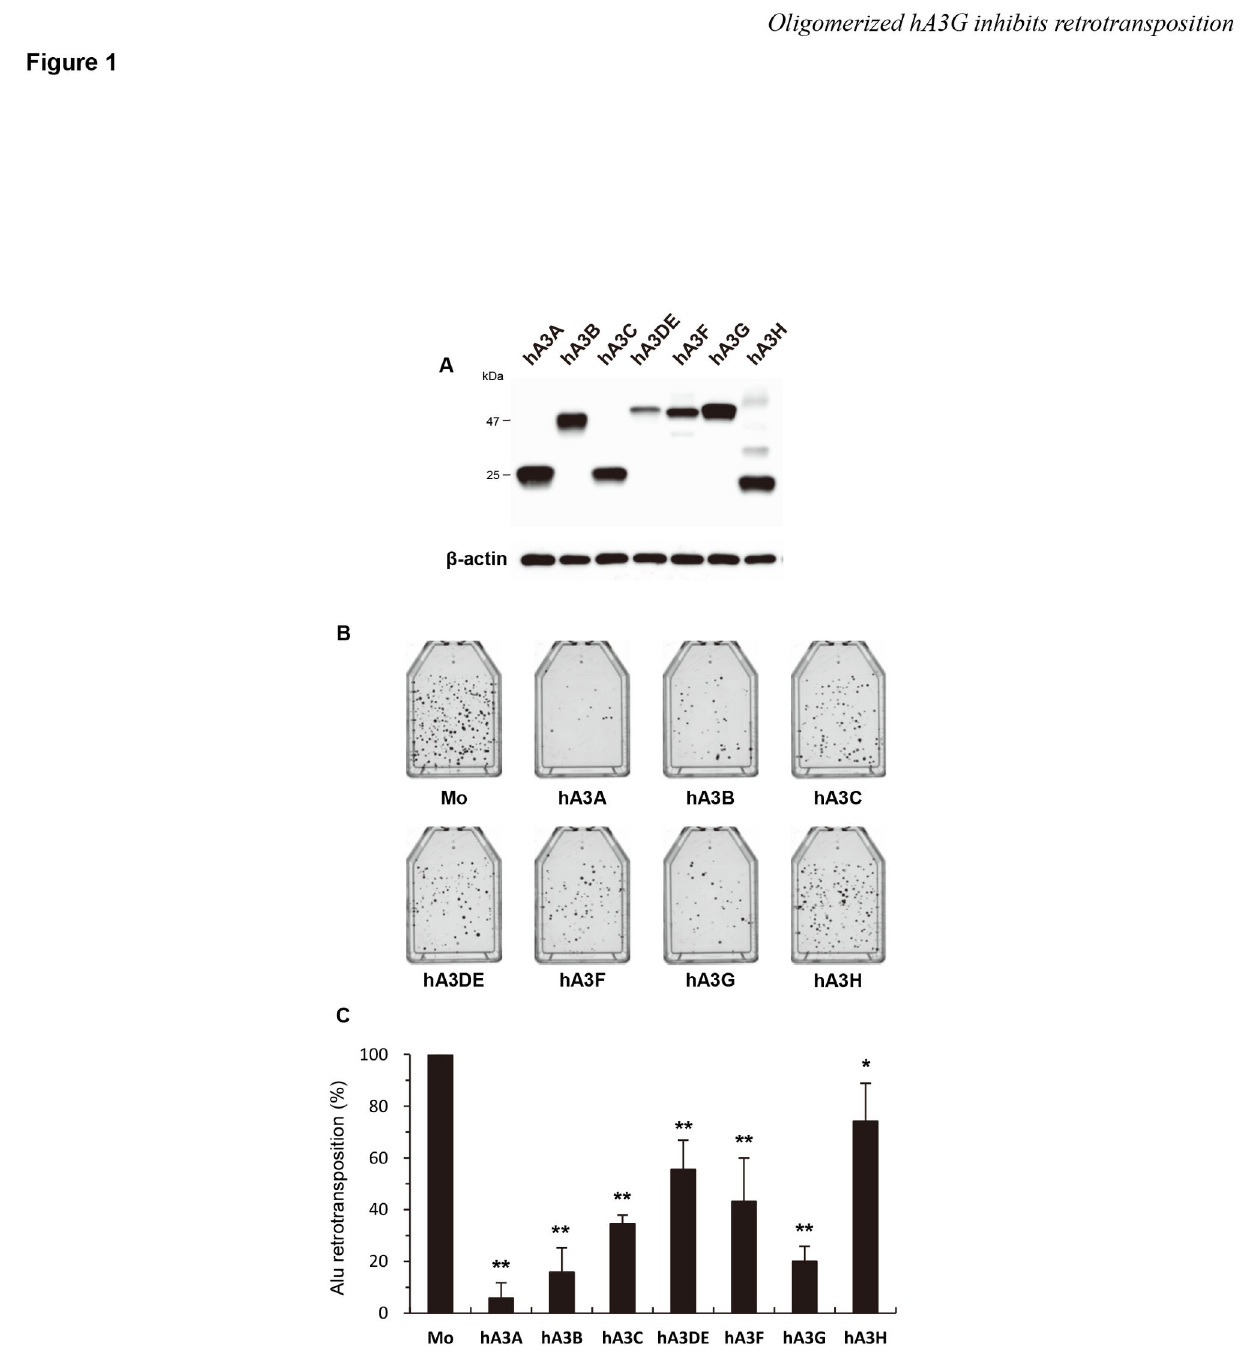
Figure 1. hA3 proteins inhibit Alu retrotransposition at differential levels. ( A ) Western blot analysis was performed by using extracts from 293T cells transfected with HA-tagged hA3 expression plasmids. Antibodies specific for HA were used. ( B , C ) HeLa cells were cotransfected with the neo r -based Alu expression vector pYa5neotet and the L1 ORF2 expression plasmid pBudORF2opt, together with the respective hA3 expression plasmid. Seventy-two hours later, the cells were trypsinized, re-seeded into T25 or T75 flasks, and subjected to G418 (400 μg/ml) selection. At 14 days after selection, the resultant G418 R colonies fixed, stained with crystal violet (B), and counted to determine the level of Alu retrotransposition (C). The retrotransposition level in the absence of hA3 proteins was set to 100%. The data shown are the mean ± SD of triplicate experiments. Mo, mock. * P < 0.05, ** P < 0.005, t -test.